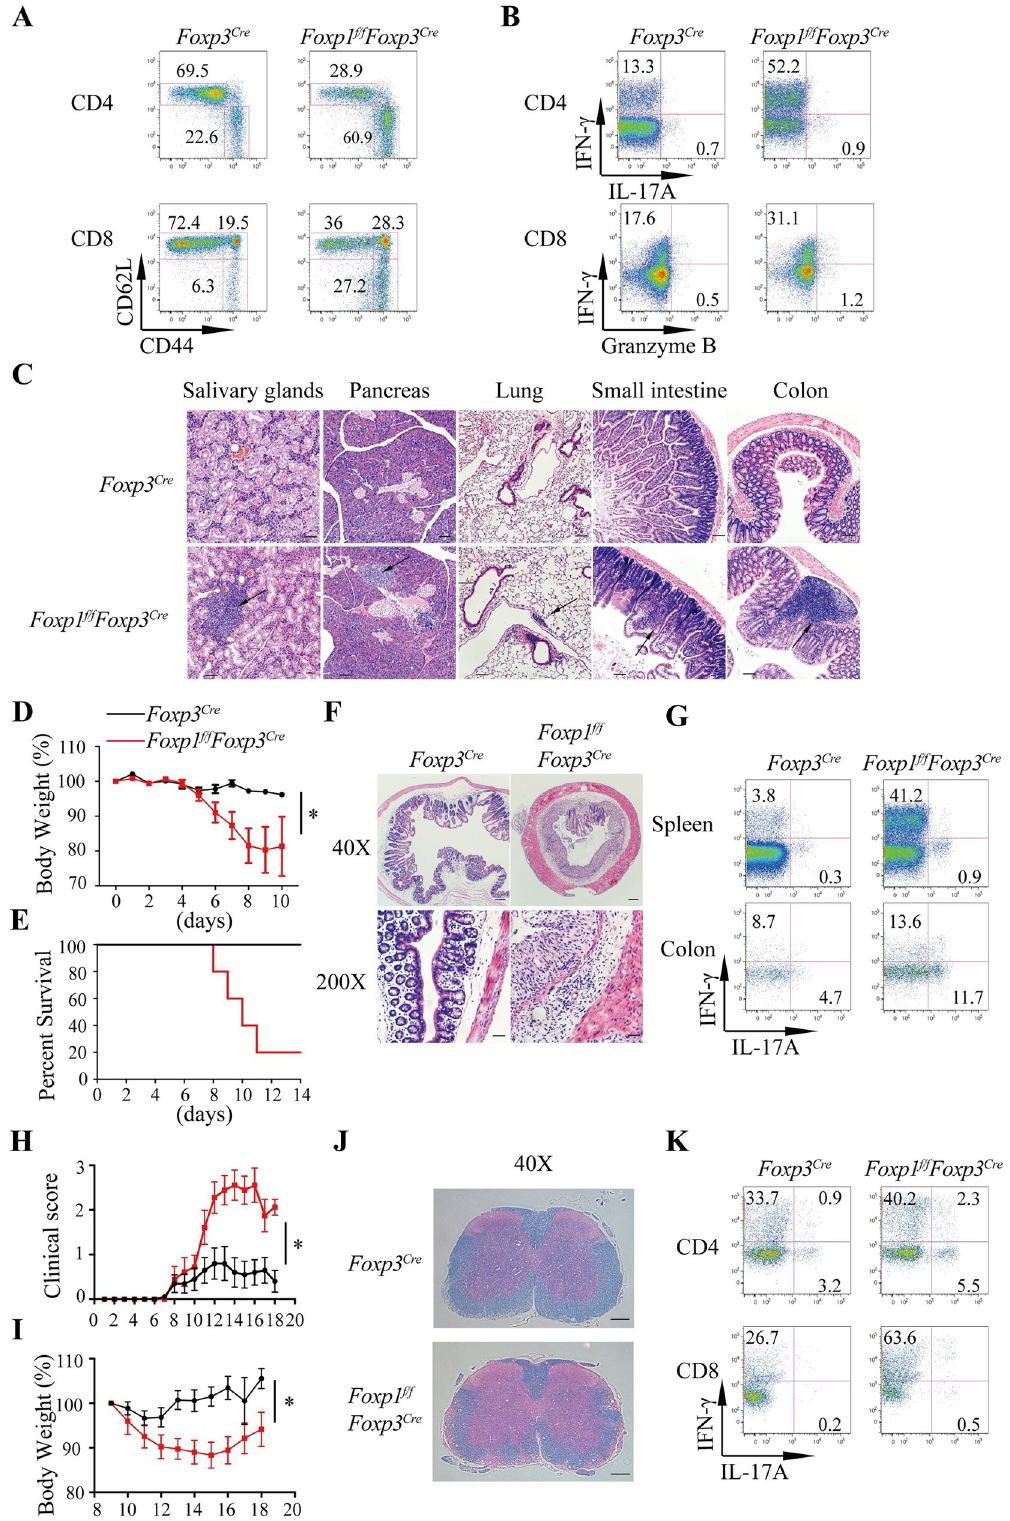
Fig 4. Foxp1 regulates Treg suppressive function. (A) Flow cytometry analysis of CD44 and CD62L expression in conventional CD4 + T cells (YFP − CD4 + ) and CD8 + T cells in the spleens of 28-week-old Foxp3 Cre and Foxp1 f/f Foxp3 Cre